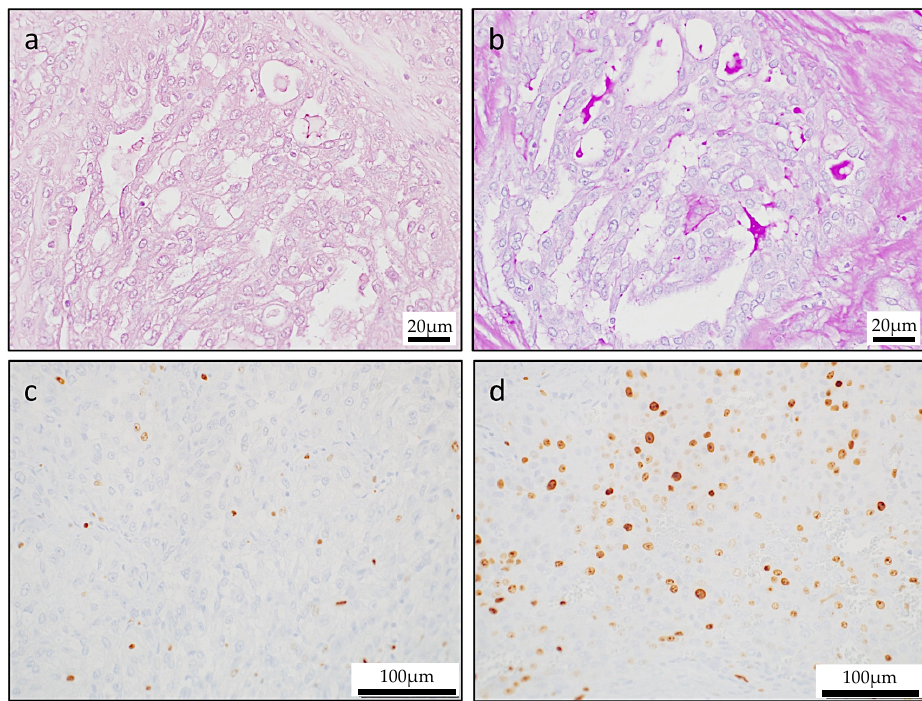
Figure 5. Special stains and Ki-67 labeling index. ( a ) Mucicarmine staining revealed mucinous cells in the tumor. ( b ) Diastase-digestion periodic acid-Schiff (PAS) staining revealed diastase-resistant PAS-positive globules. In the primary lesion, the Ki-67 labeling index was low in the papillary area ( c ), but the Ki-67 labeling index was high in the solid area ( d ).